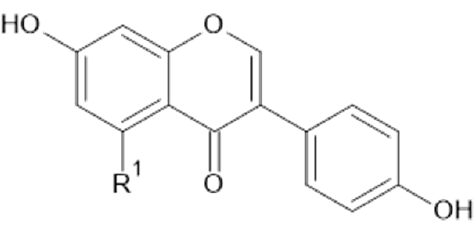
Figure 7. Chemical structure of compound 39 (R 1 = OH; MW = 270) and 40 (R 1 = H; MW = 254).